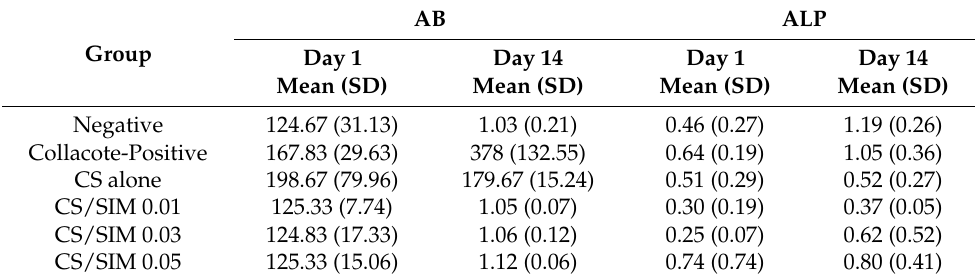
Figure 5. Alizarin red S staining images of the SIM dose response on ( A ) day 1 and ( B ) day 14. SIM, simvastatin. Arrows indicate mineralized matrix formation. Table 1. AB and ALP data in days 1 and